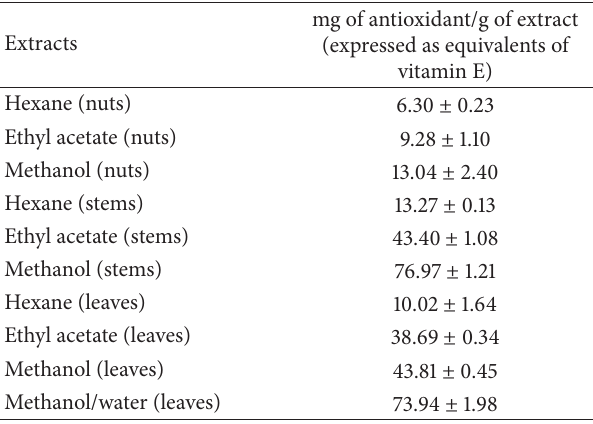
Table 6: IC of different extracts from chetoui O. europaea variety. 50 Extracts IC